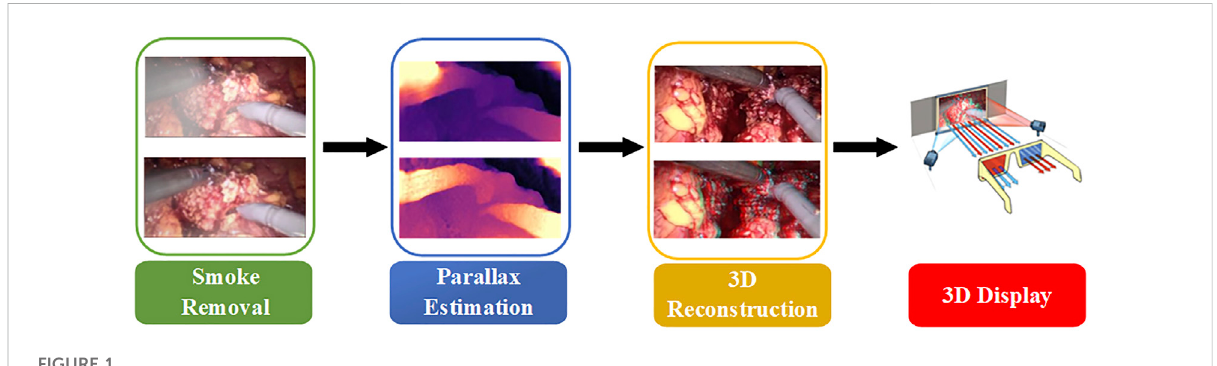
FIGURE 1 Overall process fl ow chart.